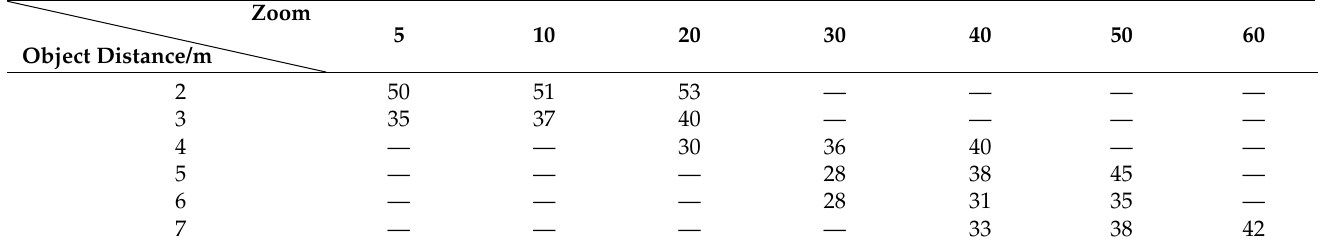
Table 2. The best focus under each object distance and zoom.